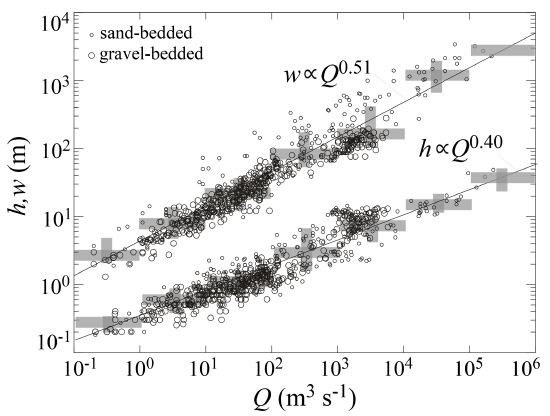
Figure 4. Plots of bank-full depth, h , and width, w , as a func- tion of bank-full discharge, Q , from the Dunne and Jerolmack (2018) global dataset, along with least-squares linear regressions of the logarithms of the data, indicating b = 0 . 512 ± 0.007 and k = 0 . 402 ± 0.006 for this dataset.